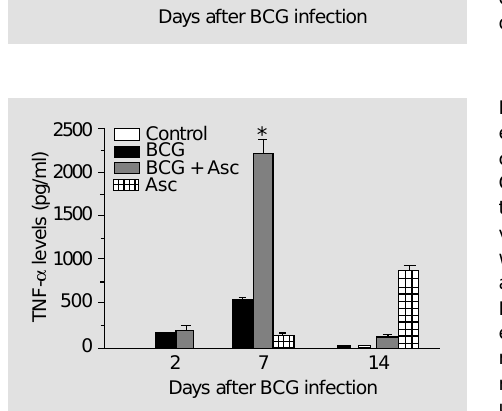
Figure 2 - Effect of Ascaris suum extract on NO production in C57Bl/6 mice. NO was meas- ured with the Griess reagent. Peritoneal cells (2 x 10 5 ) were incubated for 48 h with 10 µg/ml of BCG antigen at 37 o C in 5% CO 2 and absorbance was deter- mined at 540 nm. Results are reported as mean ± SD of one representative experiment with duplicate measurements per data point.